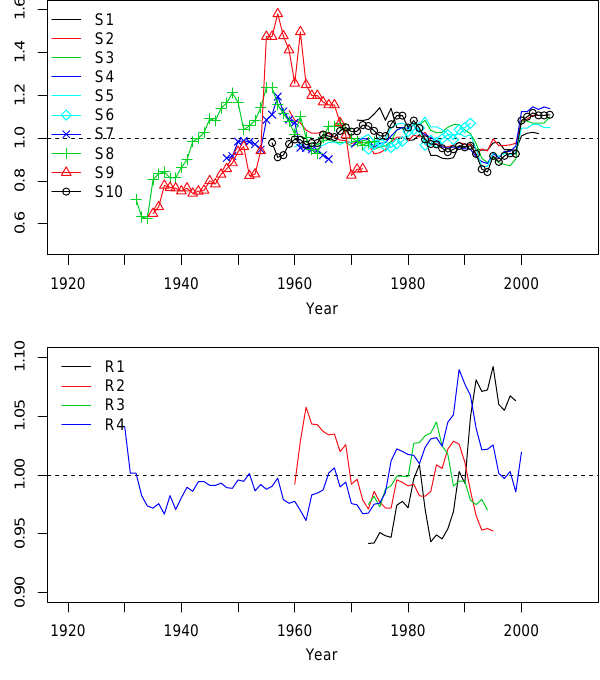
Fig. 5. Streamflow (top panel) and rainfall (bottom panel) data: running average exceedances above threshold over successive periods of (the previous) 15 years, and made dimensionless by the long term mean.